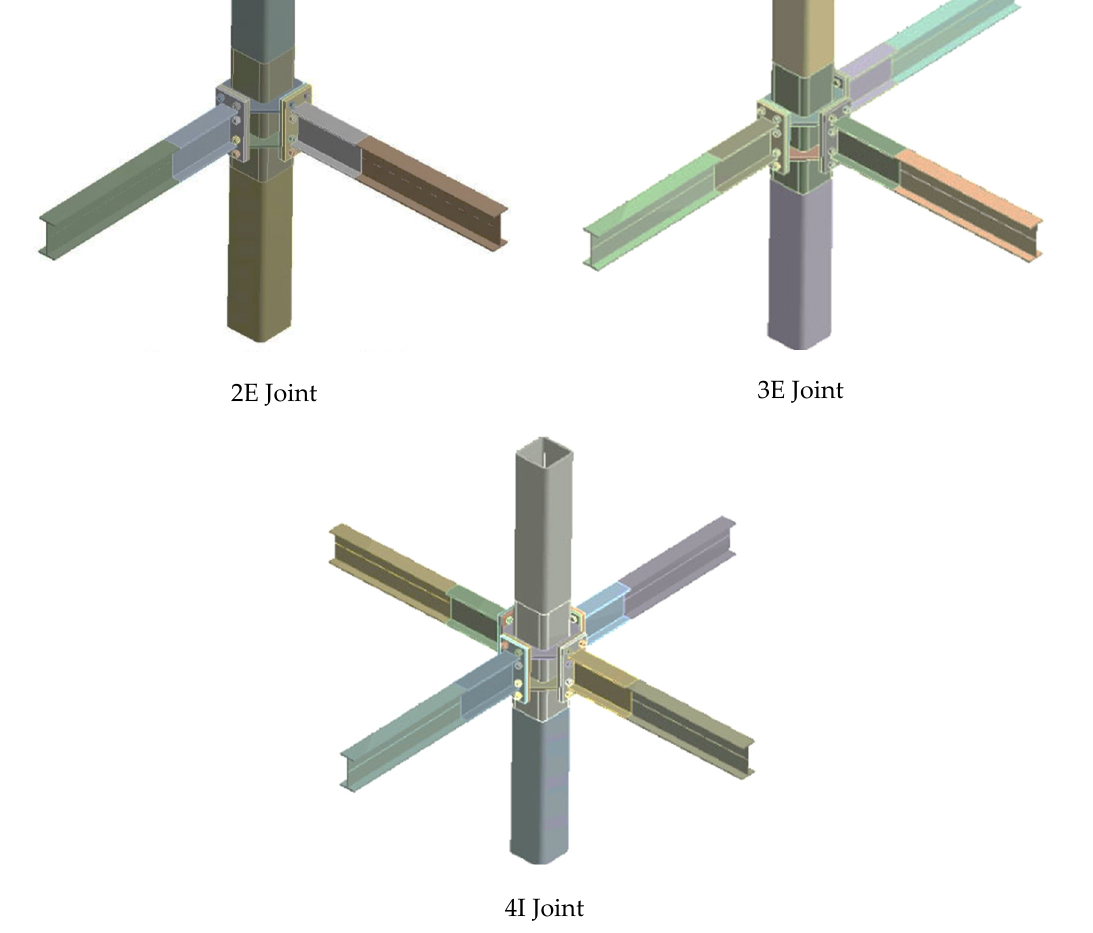
Figure 6. 2D and 3D Joint configurations studied.